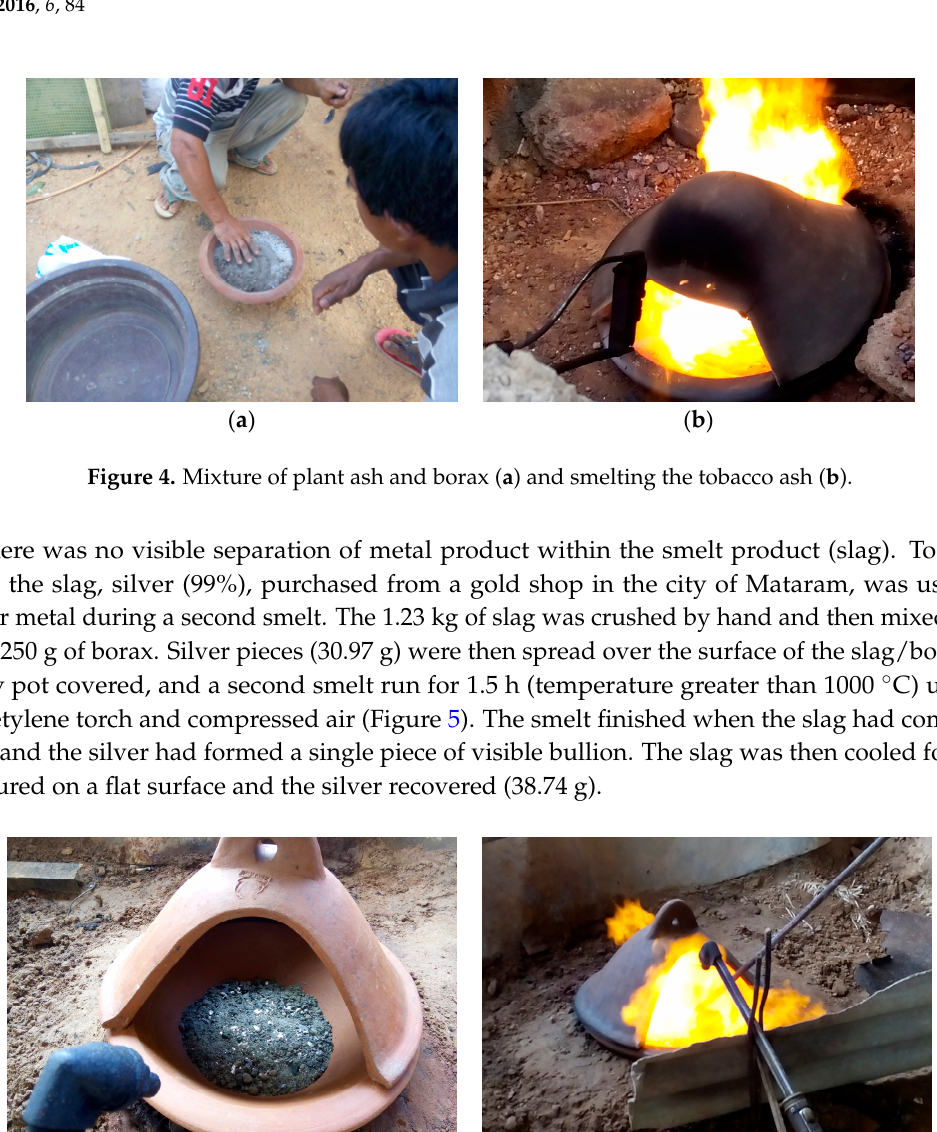
Table 4. Metal concentration in the silver and bullion determined by XRF and the calculated mass of metal in the final smelt product. Significant figures used for metal concentration based on the XRF limit of detection for each metal.